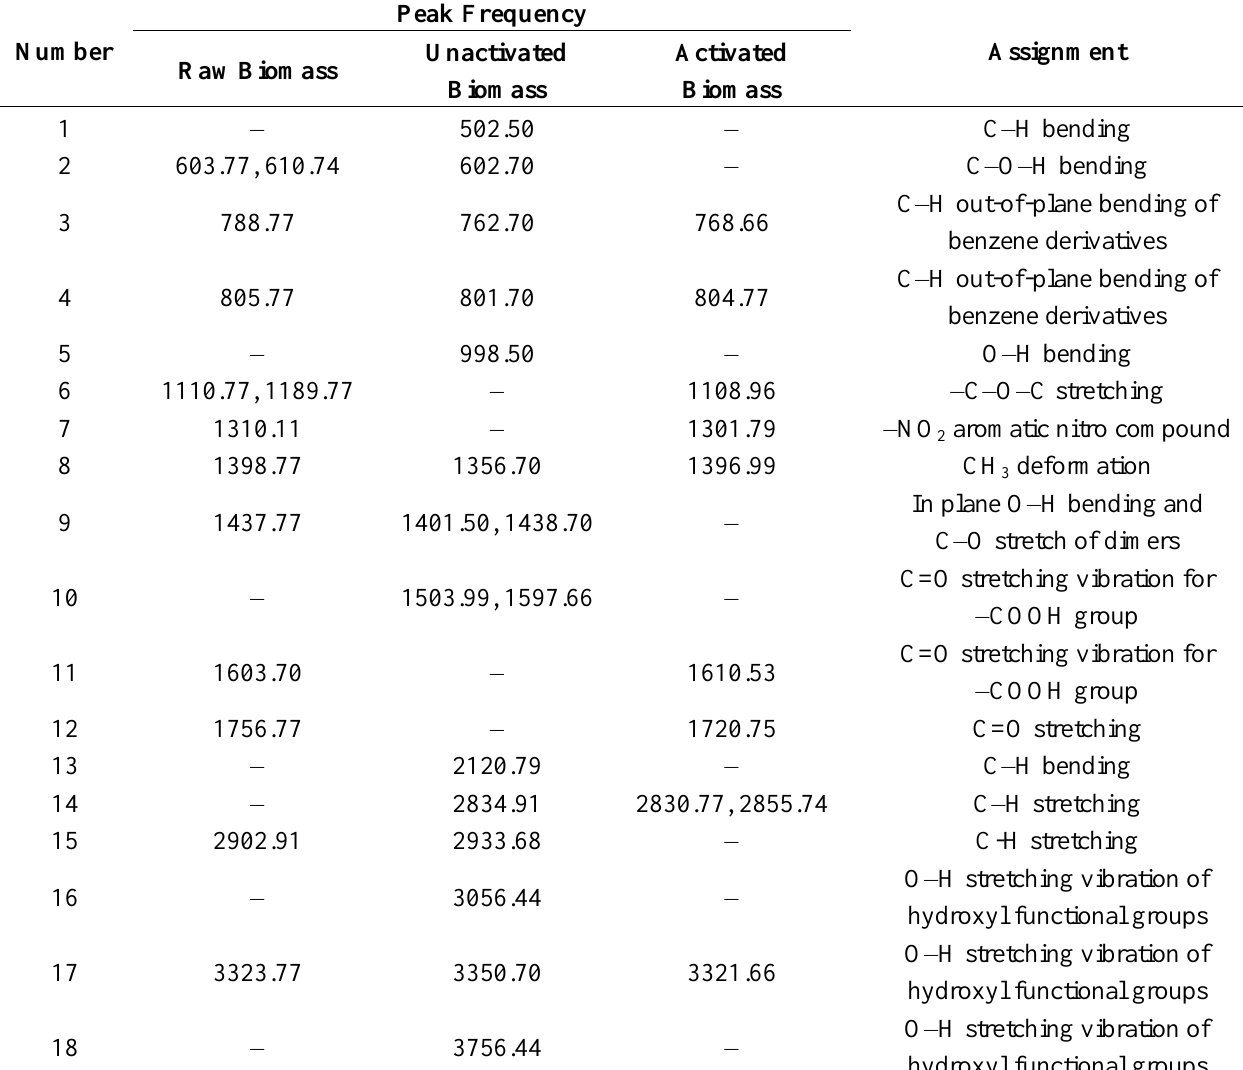
Table 1. Analysis of the Fourier transform infrared (FTIR) spectra of the raw biomass, unactivated and activated